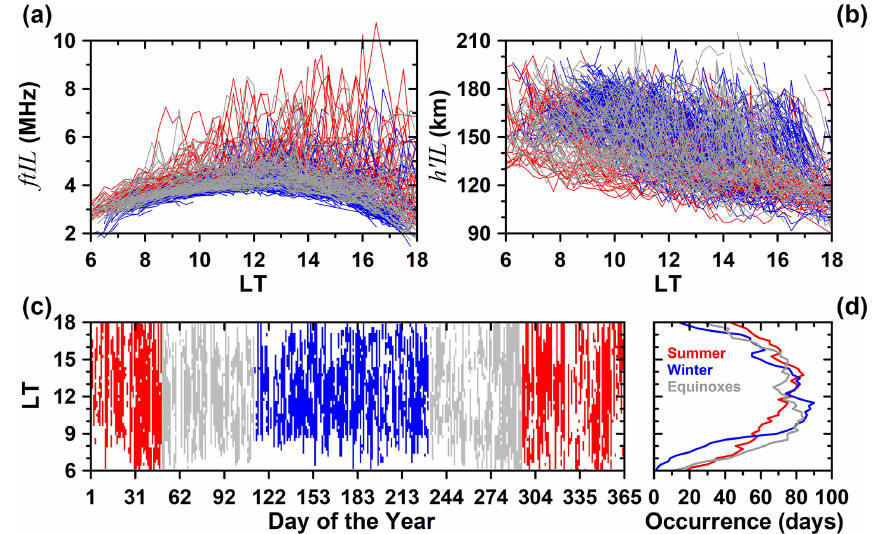
Figure 1. Behavior of the frequency (ftIL) and height (h’IL) parameters of the intermediate layers over Cachoeira Paulista during 2009 ( a and b , respectively) as functions of local time; distribution of the ILs occurrence with the local time as a function of day of the year for 2009 (c) , and the seasonal occurrence probability of the ILs. In each panel, red, blue, and gray are used to represent summer, winter, and equinoxes, respectively (d)